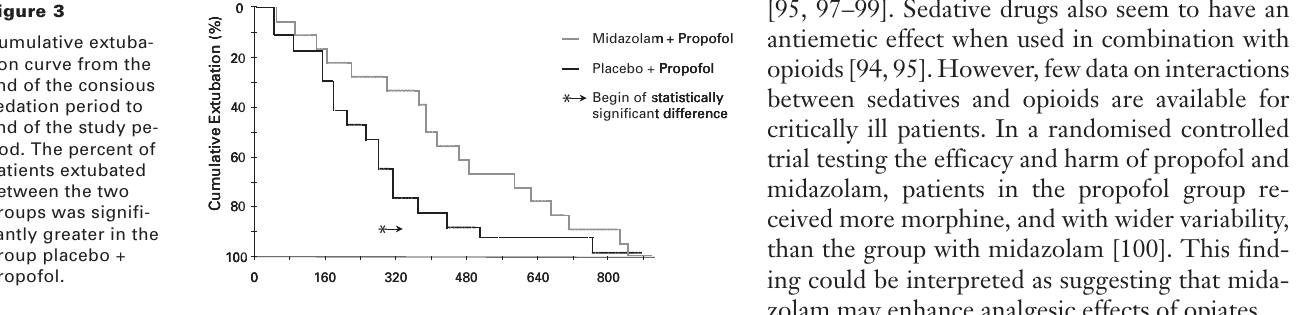
Figure 3 Cumulative extuba- tion curve from the end of the consious sedation period to end of the study pe- riod. The percent of patients extubated between the two groups was signifi- cantly greater in the group placebo +